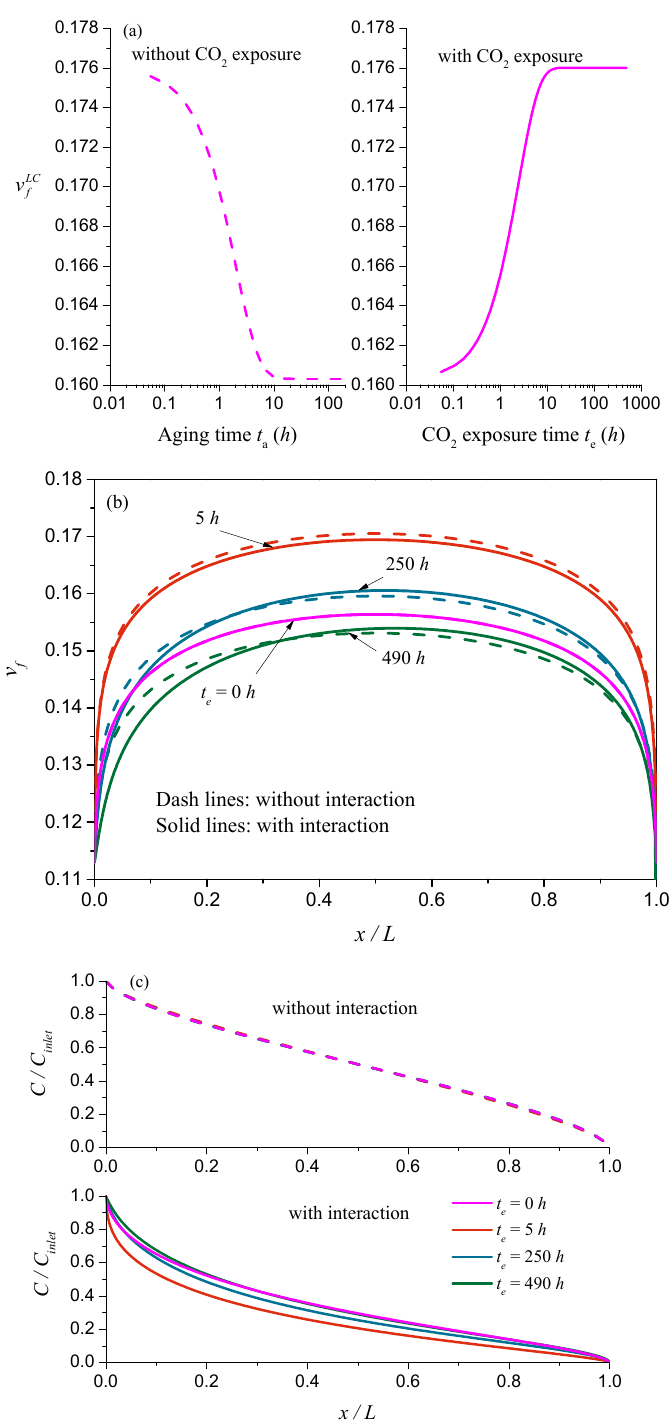
Figure 5. Simulated profiles of the lattice contraction part ( a ) and the free volume ( b ), as well as the gas concentration ( c ) across film thickness upon different aging times.